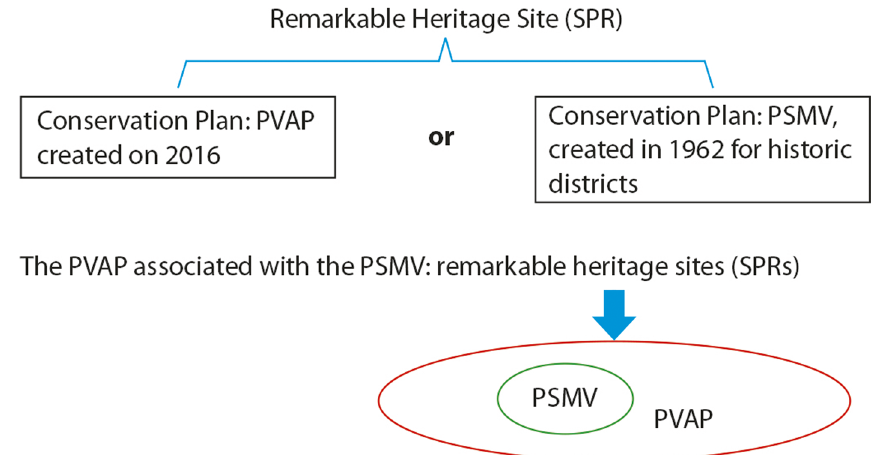
Fig. 8 The two types of protection and management plans for markable heritage sites (Source: Peng